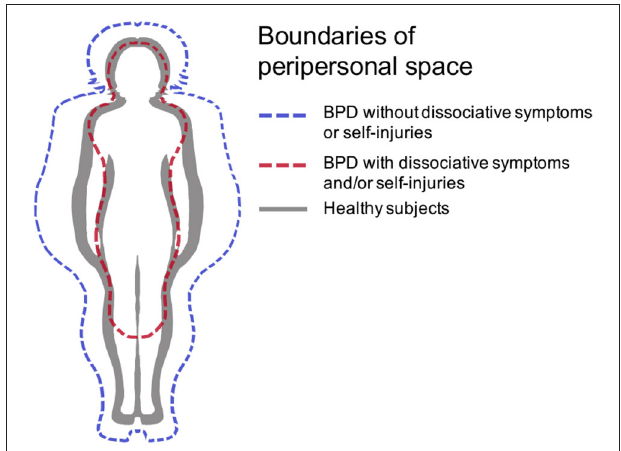
FIGURE 1 | Hypothetical boundaries of peripersonal space in BPD [adapted from (41)], in the case where it is disrupted (red dashed line) or enlarged (blue dashed